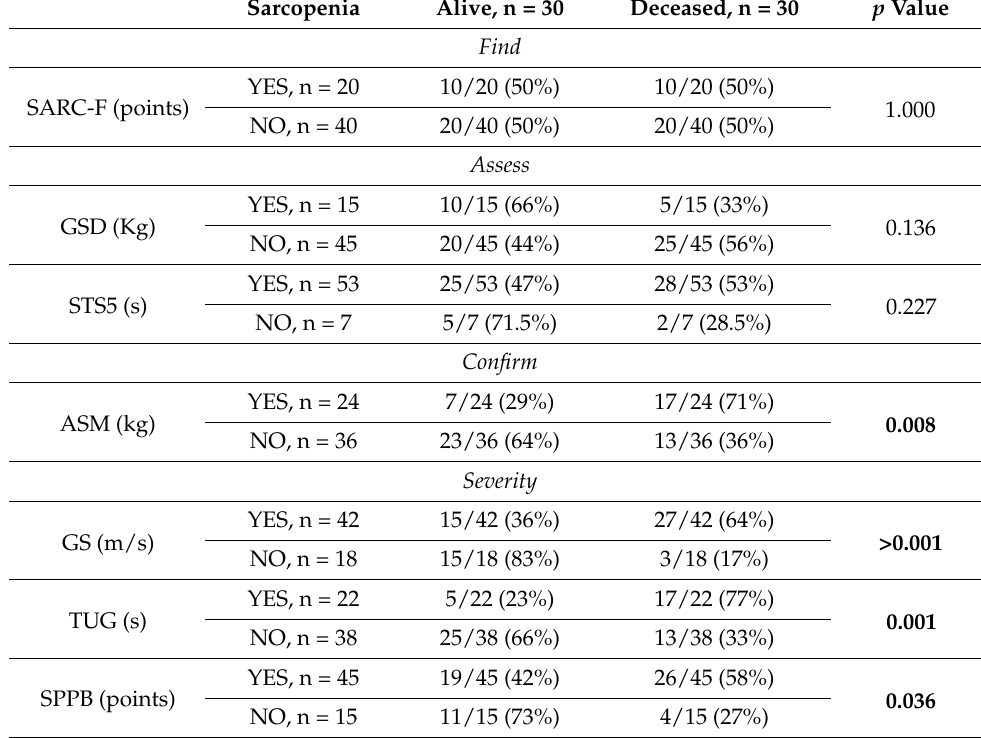
Table 5. Mortality at 2 years according to each individual variable in the EWGSOP2 diagnostic algorithm. Data expressed as n